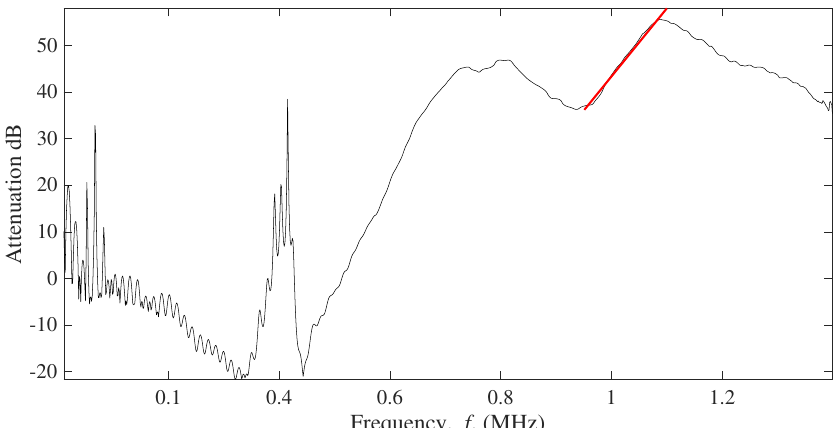
Figure 5. Example of the attenuation versus frequency curve (black solid line) with regression slope (red solid